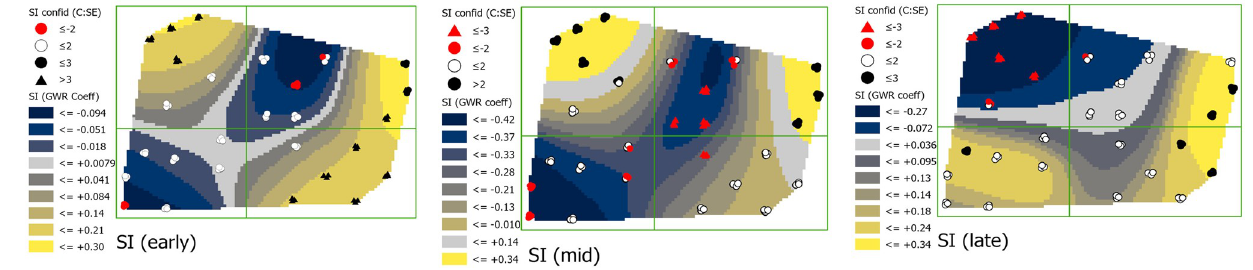
Fig 7. Maps showing early, mid-, and late season southward facing aspect (SI) coefficients with estimations of credence in coefficient values. Coefficient surface values were symbolized using a geometric interval classification scheme from blue to gold, with grey indicating the interval including zero (if